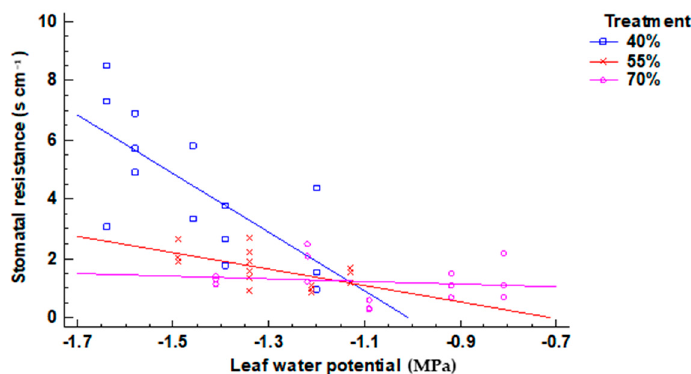
Figure 5. Linear models for regression between stomatal resistance and leaf water potential under different stress levels.